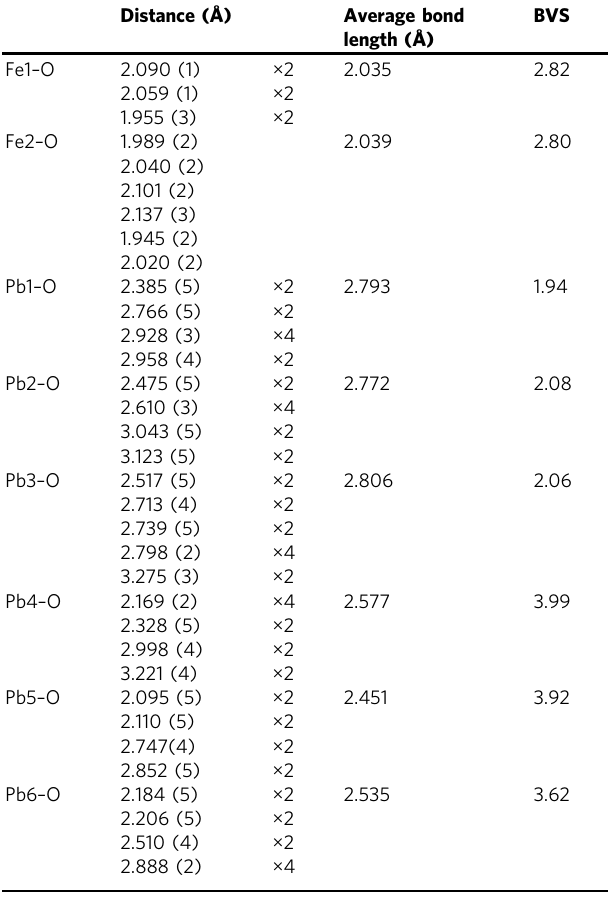
Table 2 Pb – O and Fe – O bond lengths and BVSs a for PbFeO 3 re fi ned from NPD pattern at